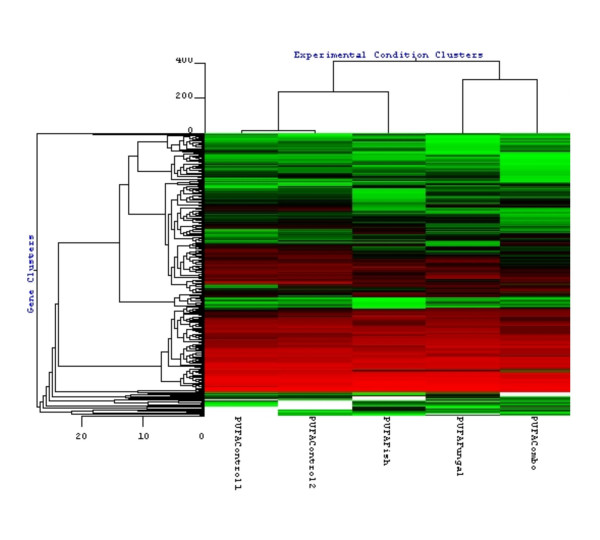
Hierarchical clustering of significant probes. Left, probe clusters; top, diet clusters; center, heat map, where red = high; black = middle; green = low. As expected, the two CONT groups clustered together.